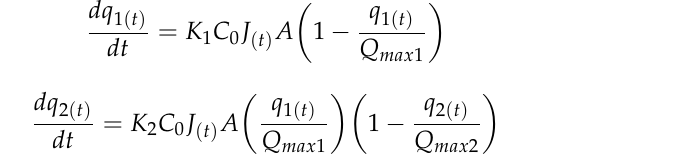
Figure 1. Schematic of filtration in a ( a ) PE membrane, and a ( b ) silica-deposited membrane. The water-permeation flux, J m 0 , through the PE membrane was determined at 0.05 MPa. The rates of colloid adsorption to the pore and previously adsorbed colloid surfaces are represented by Equations (7) and (8), respectively: